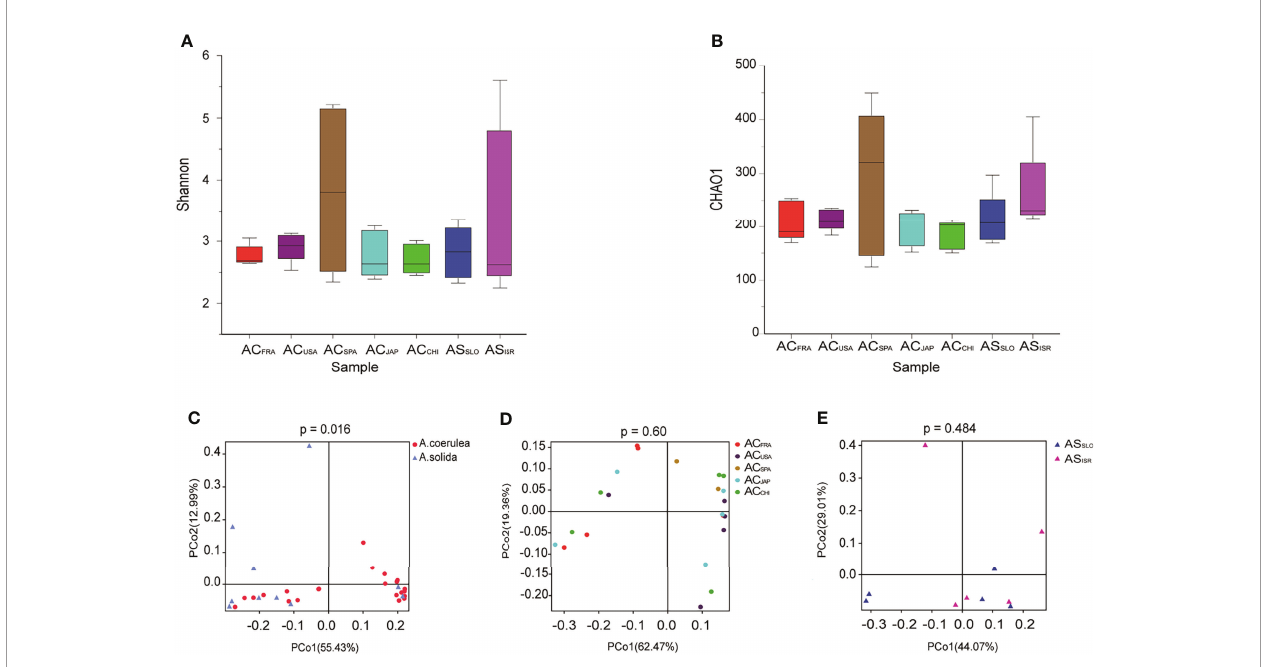
FIGURE 3 | Variation in microbial diversity of different polyp groups. Alpha diversity and richness are represented by Shannon indices (A) and CHAO1 (B) of Aurelia polyp microbiomes. PCoA (Principal coordinates analysis) visualization of bacterial beta - diversity of (C) all samples grouped by different types without outline, (D) A . coerulea polyps samples grouped by location without Outliers, and (E) A. solida polyp samples grouped by location. PERMANOVA tests were used to analyze signi fi cant differences between microbial diversity in different